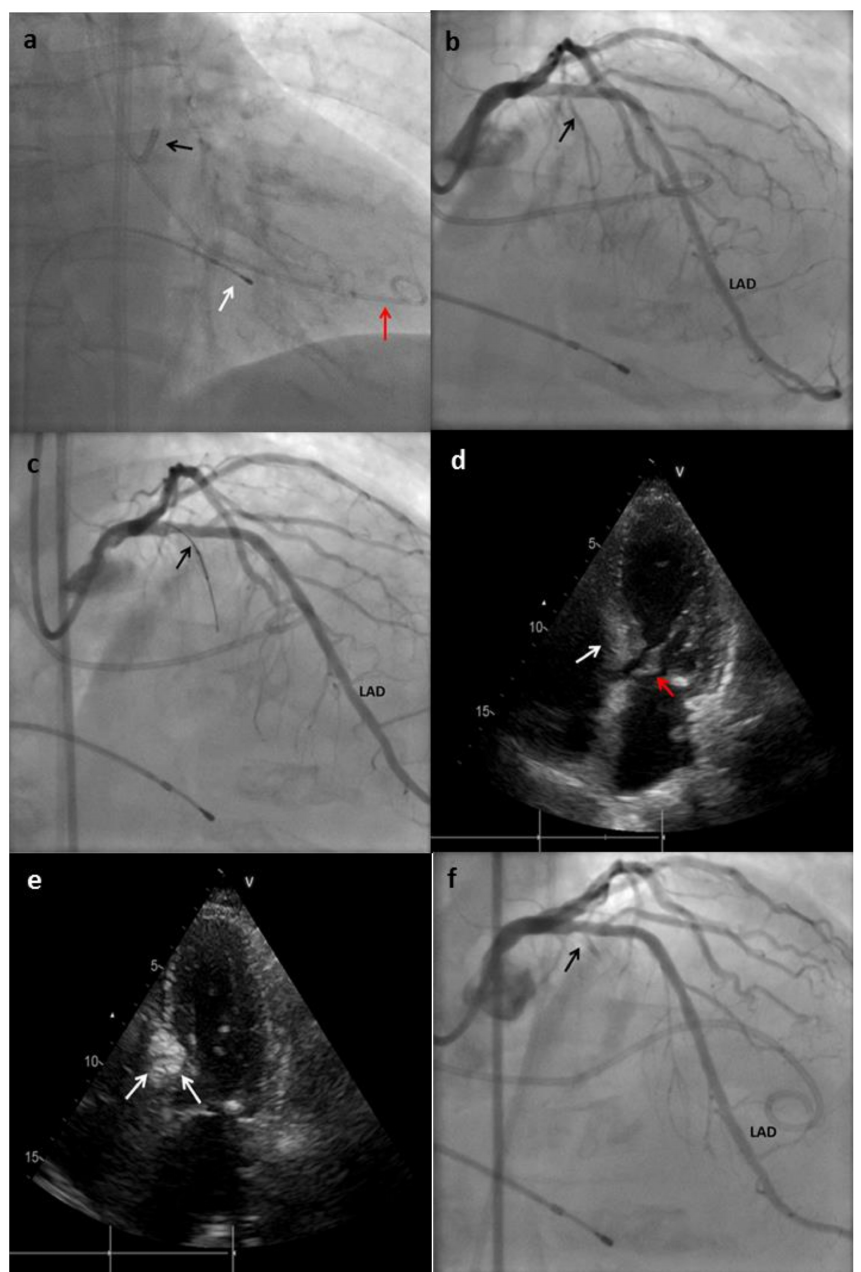
Figure 2. Main steps of the ASA technique performed in a patient at our center. ( a ) An extra back-up (EBU) catheter was placed on the ostium of the left main (black arrow); a pig-tail catheter was placed in the left ventricle (LV) for gradient monitoring (red arrow); temporary pacemaker (PM) electro-catheter was placed on the right ventricle (RV) (white arrow). ( b ) Coronary angiogram showing absence of atheroscletic lesions and the origin of the first septal branch (black arrow). LAD: left anterior descending. ( c ) The first septal branch is wired and an over-the-wire (OTW) balloon is advanced to this artery (black arrow). ( d ) Transthoracic echocardiography (TTE) showing hypertrophy of the basal septum (white arrow), which makes contact during systole with the anterior leaflet of mitral valve (red arrow). ( e ) TTE performed after Gelafundin ® (B. Braun, Melsungen, Germany) injection in the septal branch; enhancement of the basal septum can be seen (white arrows), this indicates that the first septal is suitable for ablation. ( f ) Coronary angiogram showing final result with occlusion of the first septal branch after alcohol